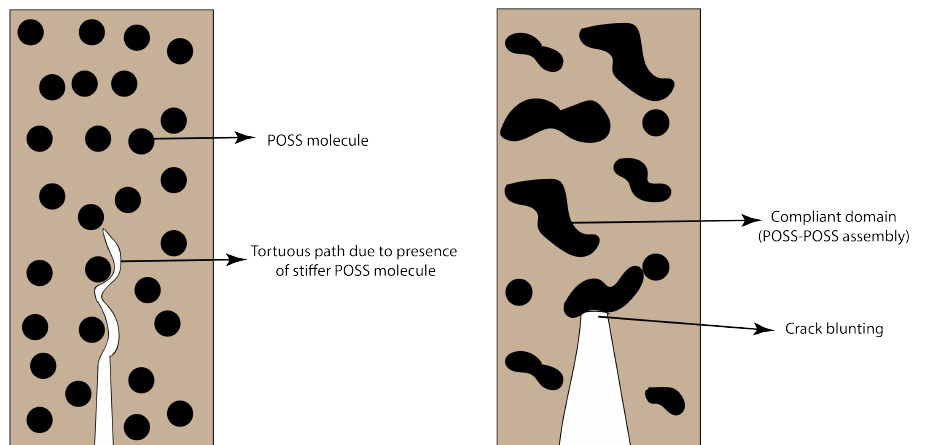
Figure 7. Fracture behavior of POSS–epoxy nanocomposites at lower ( left ) and higher loading ( right ).